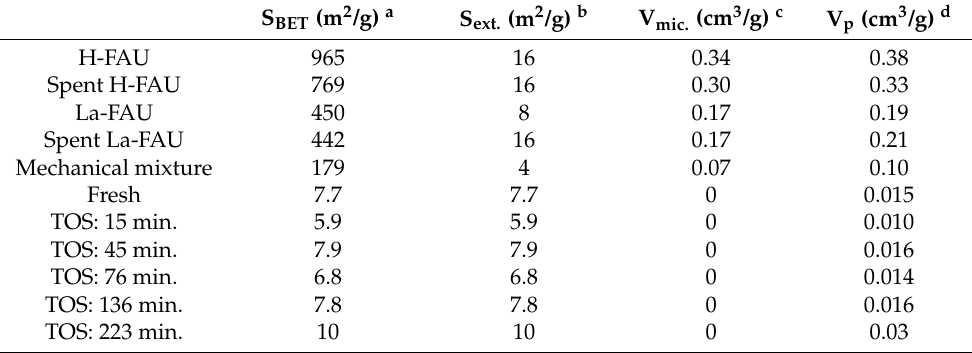
Figure 4. N 2 adsorption–desorption isotherms of ( a ) the fresh and spent pristine supports, physical mixture of S-ACl, the fresh catalyst before and after reaction (time on the stream (TOS): 223 min) in ethane ODH (isotherms corresponding to the fresh catalyst shifted along the y-axis by an increment of 20 cm 3 /g), ( b ) the spent catalysts after different TOS under reaction atmosphere (isotherms are shifted along the y-axis by an increment of 4 cm 3 /g). Table 2. Textural properties of the support (La-FAU), mechanical mixture of S-ACl, fresh, and spent catalyst after the ethane ODH reaction in different